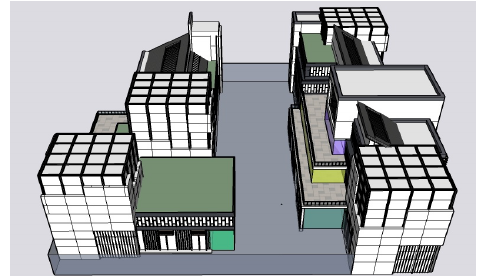
Figure 14. A street formed by two buildings.